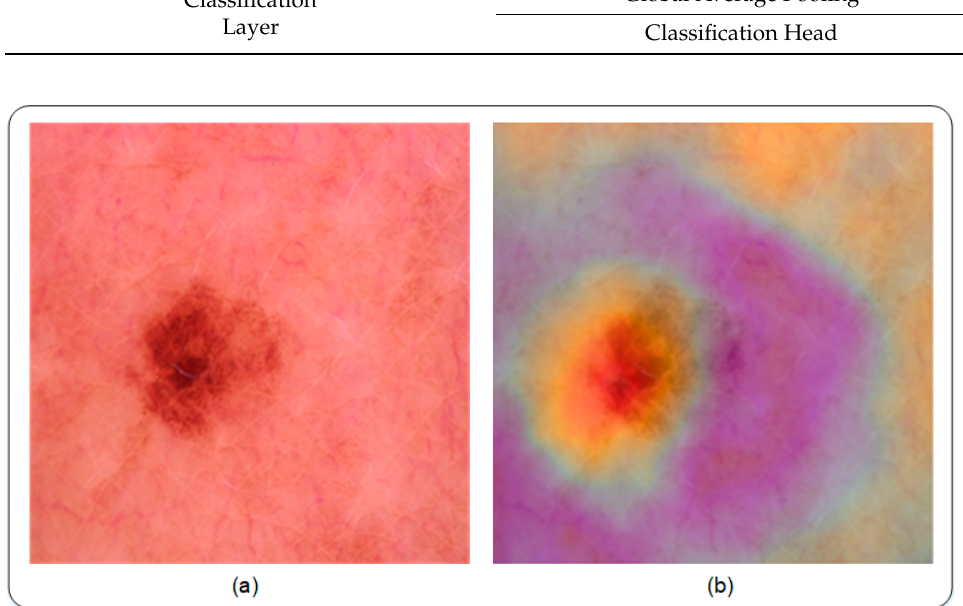
Figure 6. A visual illustration of localization using Grad-CAM. ( a ) shows the input image and ( b ) depicts the lesion being weakly localized in the image using Grad-CAM. The result presented in ( b ) demonstrates the fact that Grad-CAM is capable of localizing lesion present in the